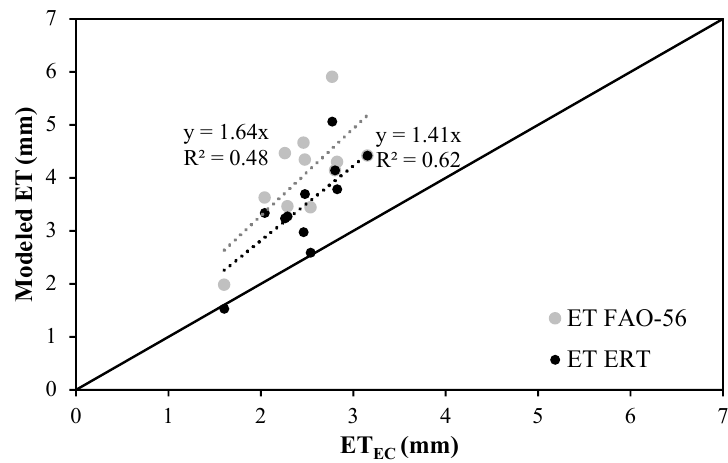
Figure 8. Comparison between modelled ET FAO and ET ERT versus measured ET EC . The black solid line represents the 1:1 relationship.